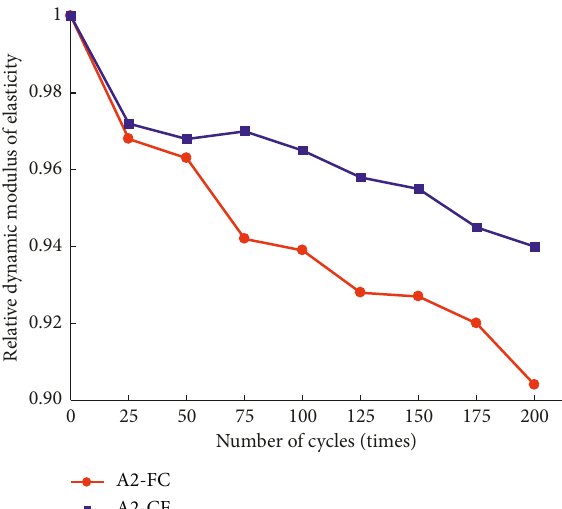
Figure 7: Relative dynamic modulus of elasticity of A2 subjected to alternating freeze-thaw cycles and carbonation.